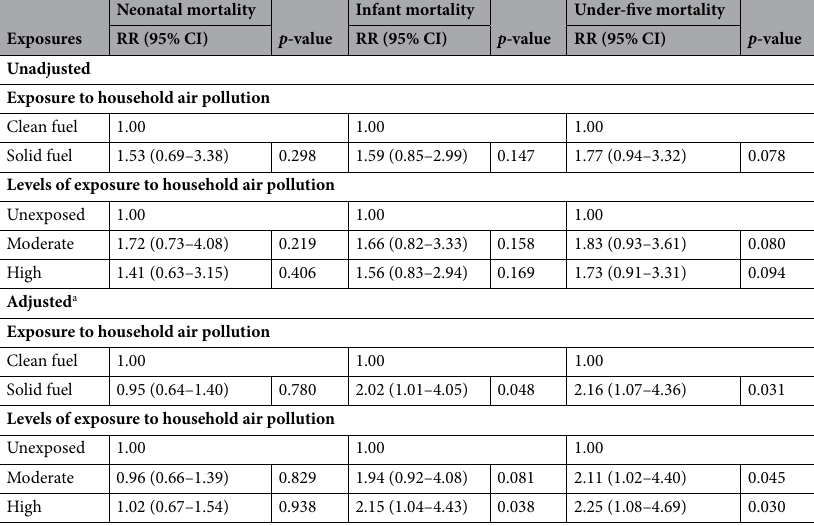
Table 3. Associations between HAP exposure and risk of neonatal, infant, and under-five child mortality in Myanmar. RR relative risks, CI confidence interval. a Multilevel Mixed-effects Poisson Regression models were adjusted for child age, child sex, breastfeeding status, maternal education, household wealth quintiles, urbanicity, geographic region, preceding birth interval and